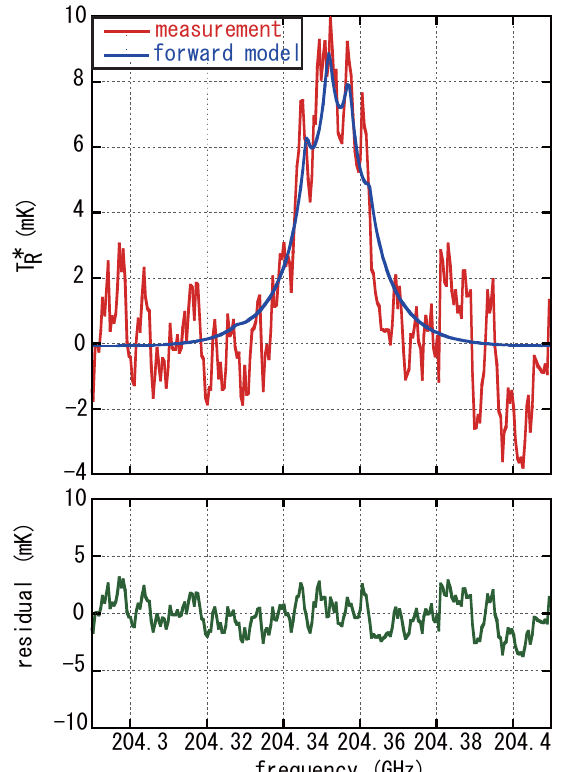
Fig. 3. (Top) Averaged ClO spectrum obtained at 12:00–15:00LT from 5 to 16 December 2009 (red) and the fitting curve with the forward model (blue). (Bottom) Residual of the fitting by the for- ward model calculation.